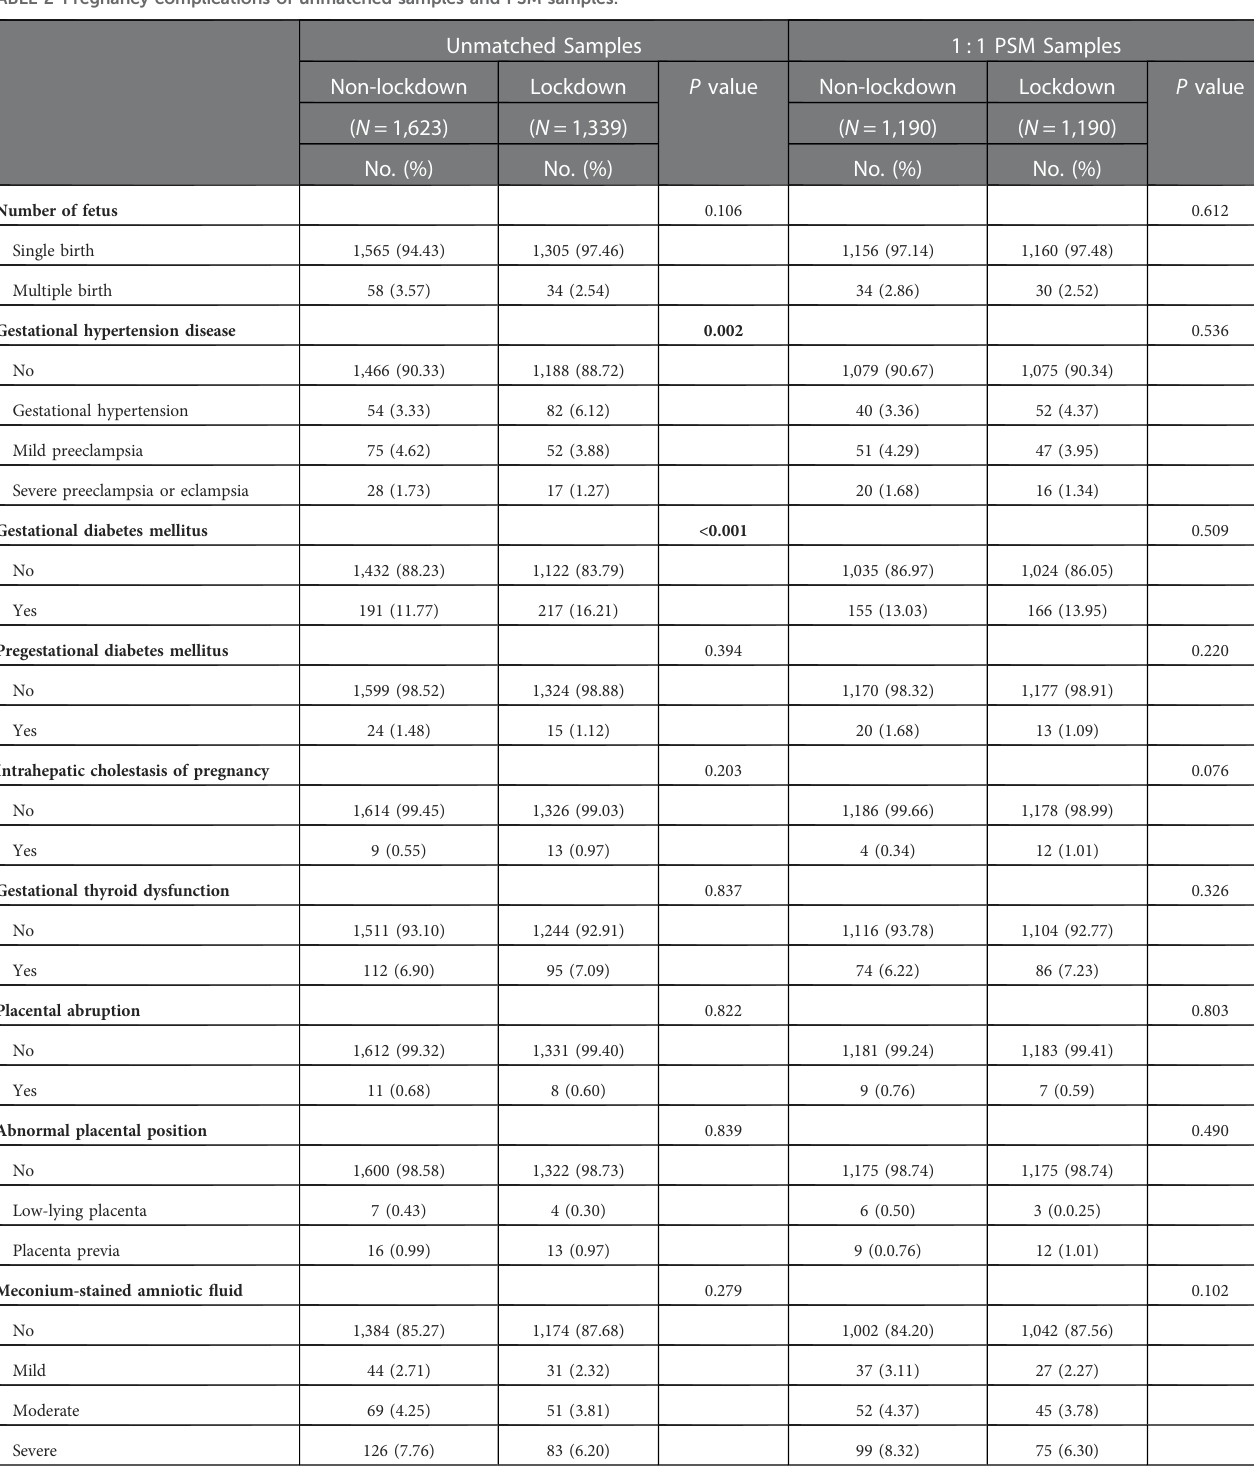
TABLE 2 Pregnancy complications of unmatched samples and PSM